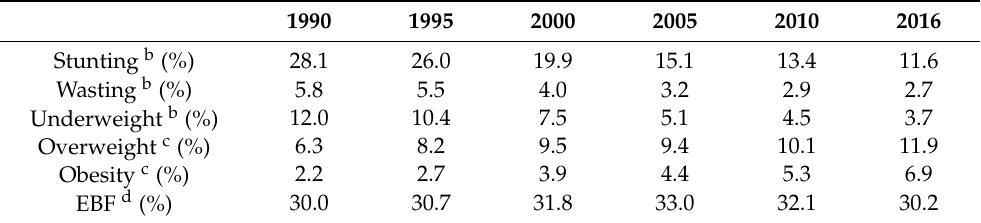
Table 1. Child nutrition trends from 1990 to 2016 in China a